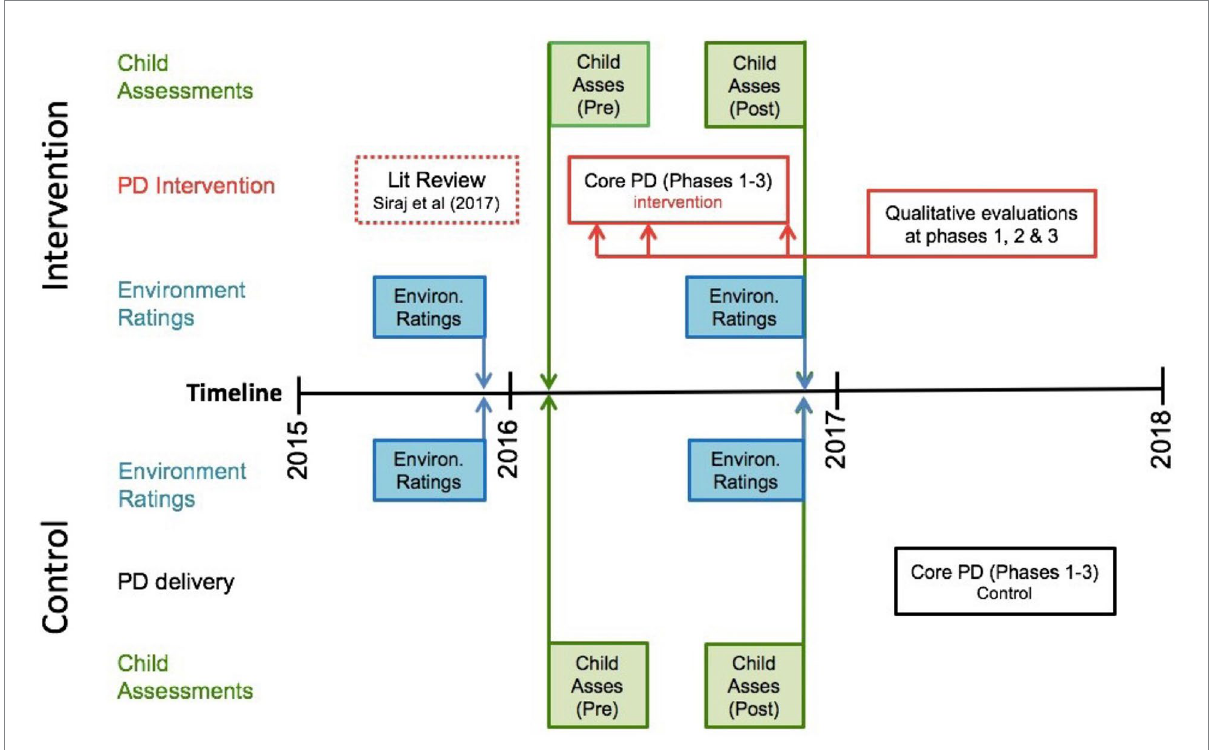
FIGURE 1 The design of the cluster RCT examines the efficacy of the leadership for learning professional